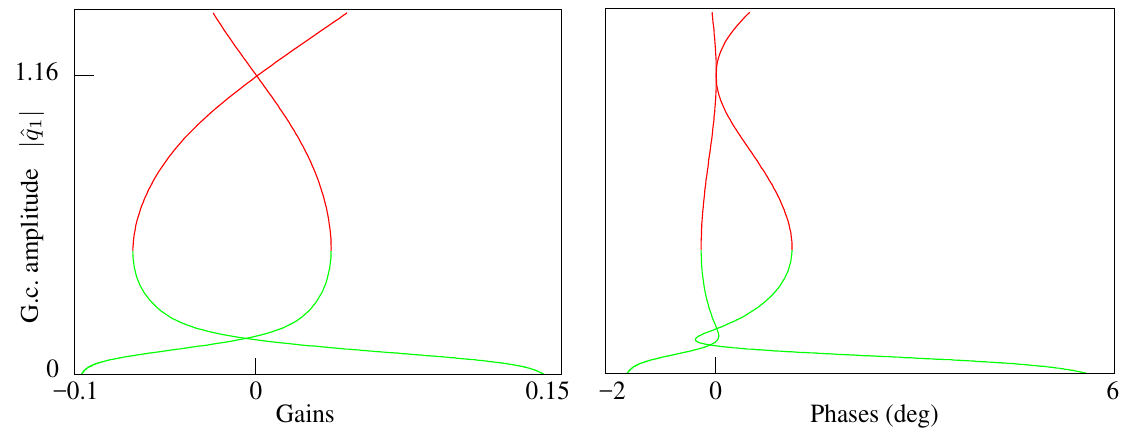
Figure 13. Reduction of an LCO amplitude with control system parameters (Green means stable, red means